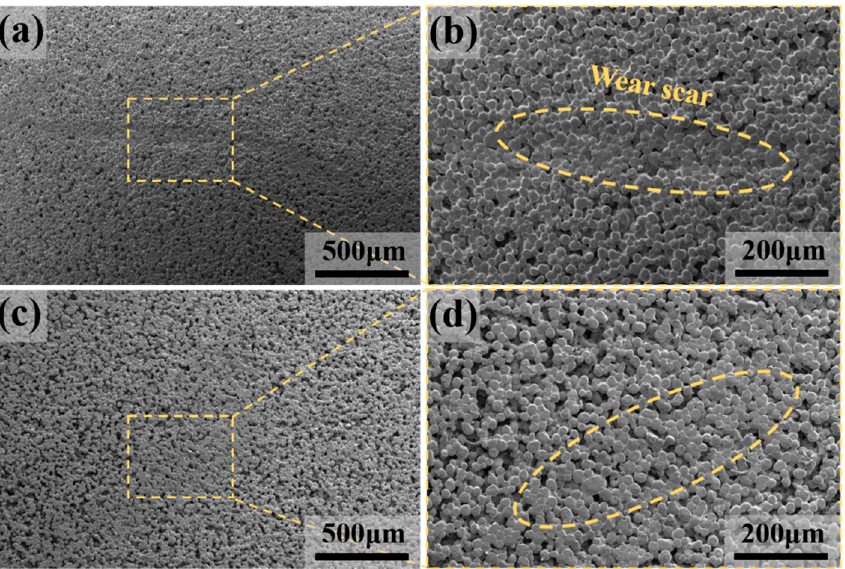
Figure 9. The SEM image of wear scar under dry friction, and ( b ) wear scar diagram in the yellow circle of ( a ) at higher magnification; ( c ) the SEM image of wear scar under oil lubrication conditions, and ( d ) wear scar diagram in the yellow circle of ( c ) at higher magnification.